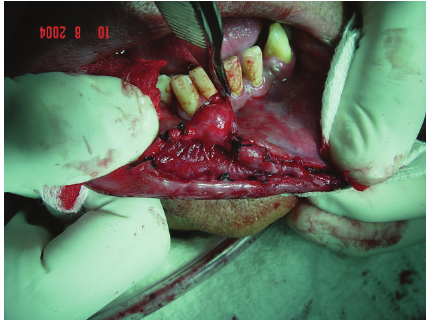
Figure 9: Microscopic examination of the specimen. No cellular changes were observed; only a normal cell structure of the arterial section was present (Hematoxylin-eosin,